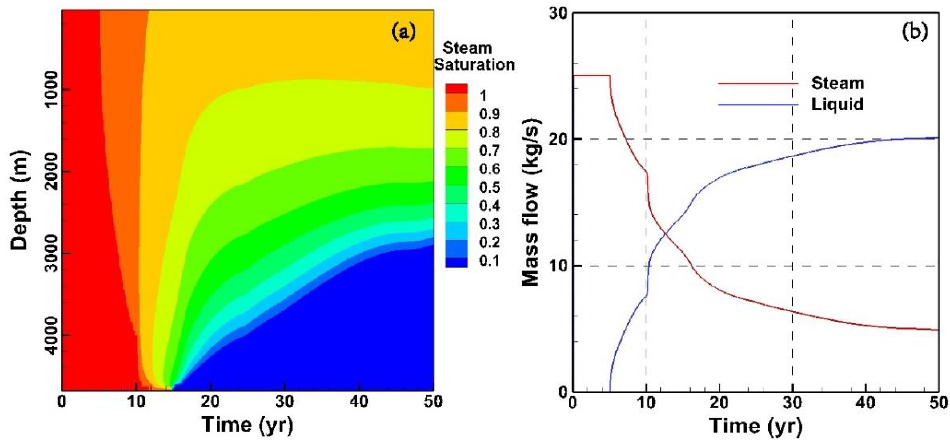
Figure 6. Gas saturation distribution in production well ( a ) and the production mass flow rate in different phases ( b ).